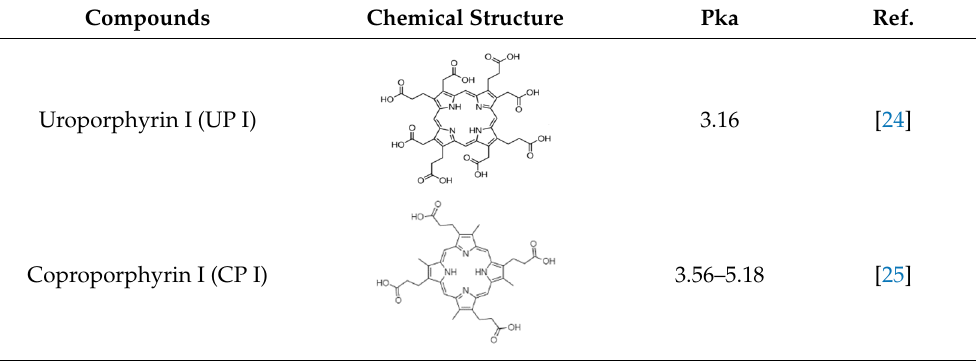
Table 1. The structures of the four natural porphyrins analyzed in this study. Compounds Chemical Structure Pka Ref.